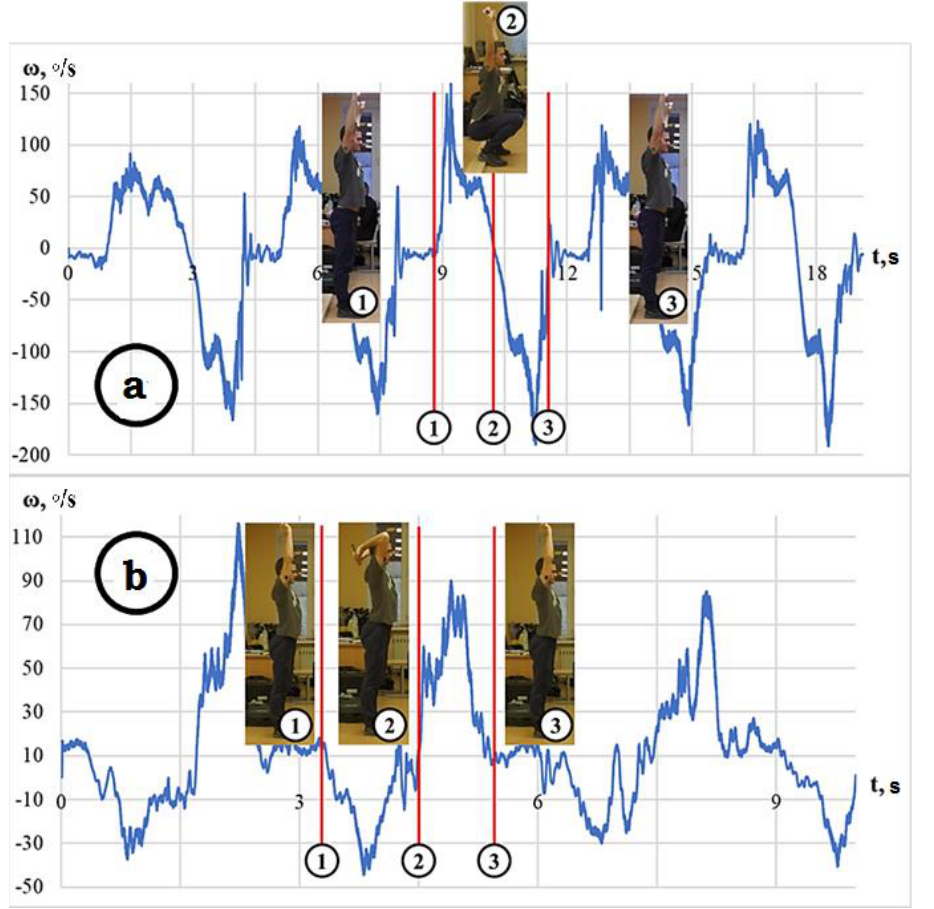
Figure 5 . Gyroscope signals from sensors located on the lower and upper limbs: a - signal from the gyroscope located on muscle "Rectus Femoris" during the squatting; b - signal from the gyroscope located on muscle "Extensor Carpi Ulnaris" during the bending of arms in the elbow